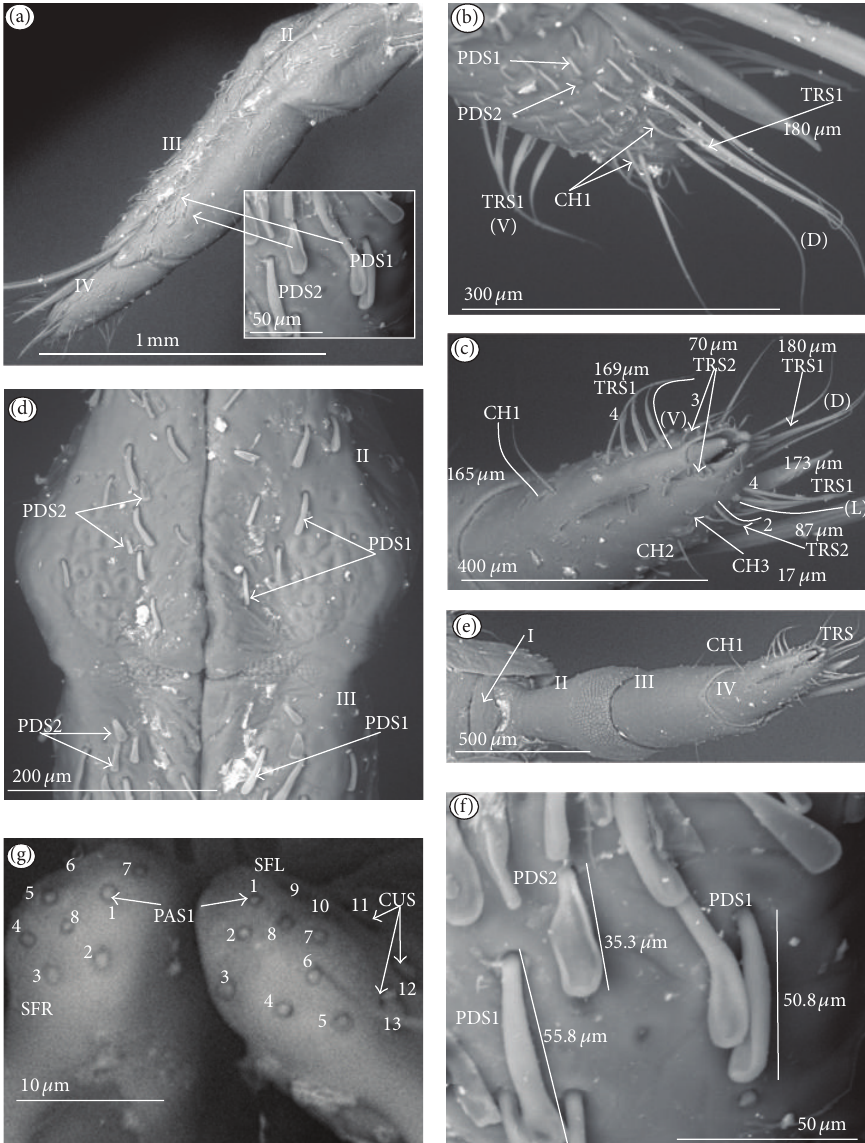
Figure 10: Types, sizes and distribution of the sensilla of the Ranatrinae ( Ranatra chinensis ). (a) PDS1, PDS2, CH1, and CH2 are irregularly distributed on the segment II, III, and IV, dorsal view. (b) TRS1 are placed dorsally (D) near the apex of the labium (fourth segment). (c) TRS1, TRS2 distributed laterally (L), and ventrally (V); CH1 and CH2 are distributed all over the surface of the last segment of the labium. (d) PDS1, PDS2 evenly distributed, dorsal view of the II and III segment. (e) Ventral view of the I, II, and III segments, sensilla are not very numerous; they seem more numerous on the IV labial segment. (f) Shapes and sizes of the PDS1 and PDS2. (g) PASI (no 1–10) distributed apically, PIP is